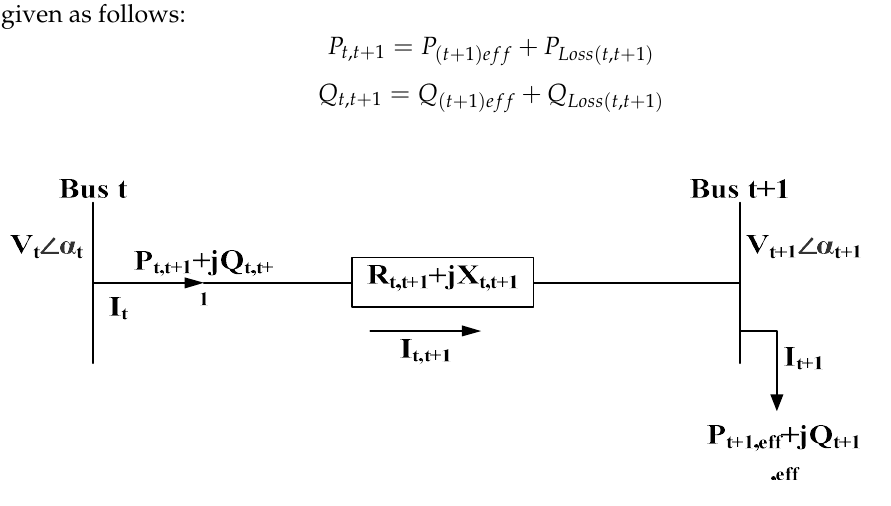
Figure 1. Sample distribution system.